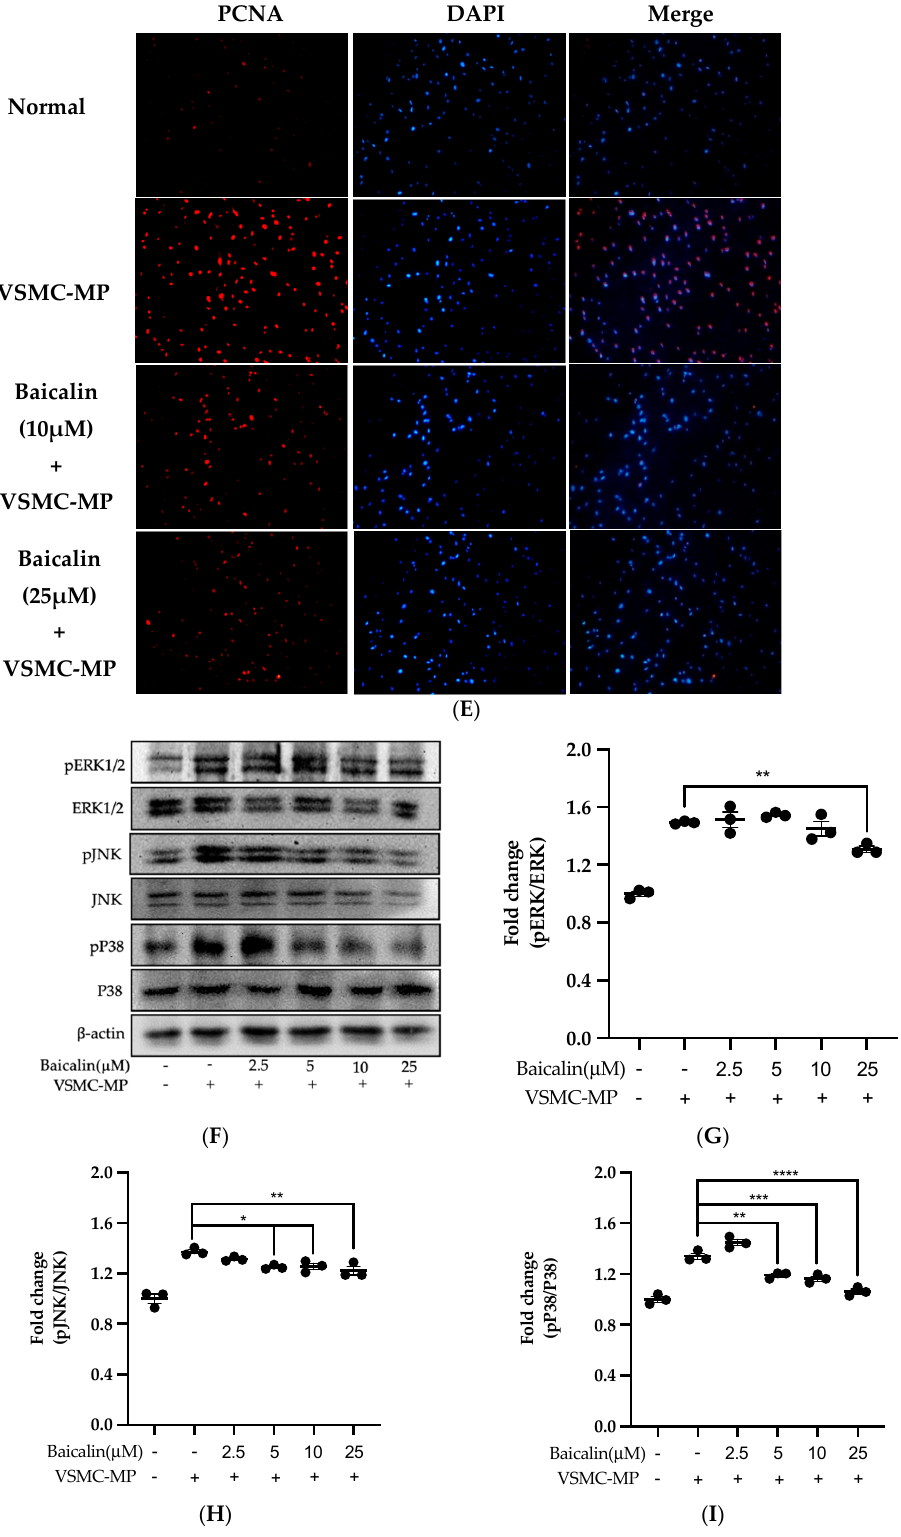
Figure 5. Effect of baicalin on VSMC-MP induced proliferation of VSMC. ( A ) VSMC were incubated with VSMC-MP and a various dose of baicalin for 48 h, followed by MTT solution for 4 h. The absorbance of purple formazan was taken at 540nm. ( B ) VSMC incubated with or without VSMC-MP and various doses of baicalin for 48 h were evaluated for proliferation by MTT method. ( C ) The cell lysate of VSMC treated with or without VSMC-MP and various doses of baicalin for 24 h and was subjected to SDS-PAGE for